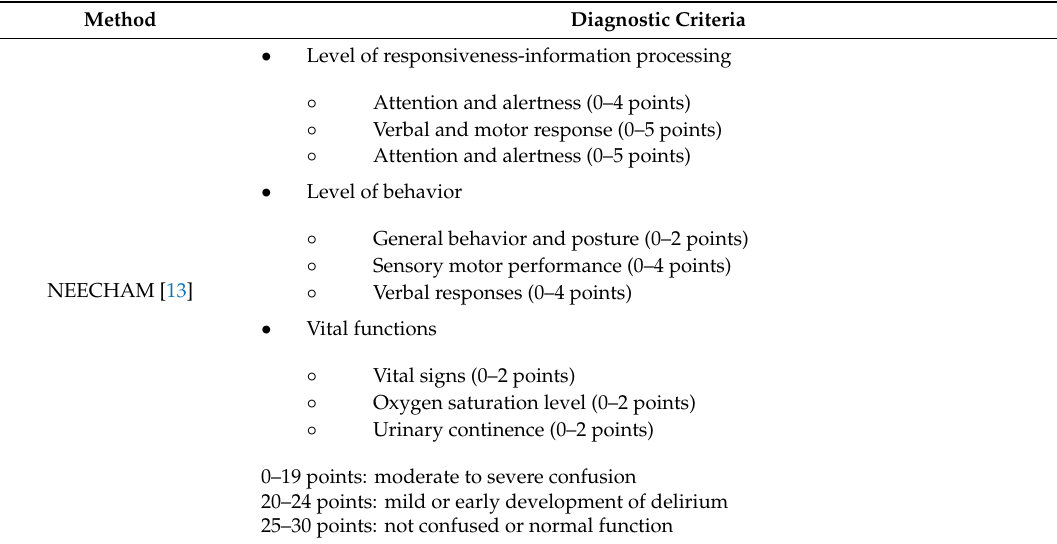
Table 1. Criteria for the diagnosis of delirium in scientific research.